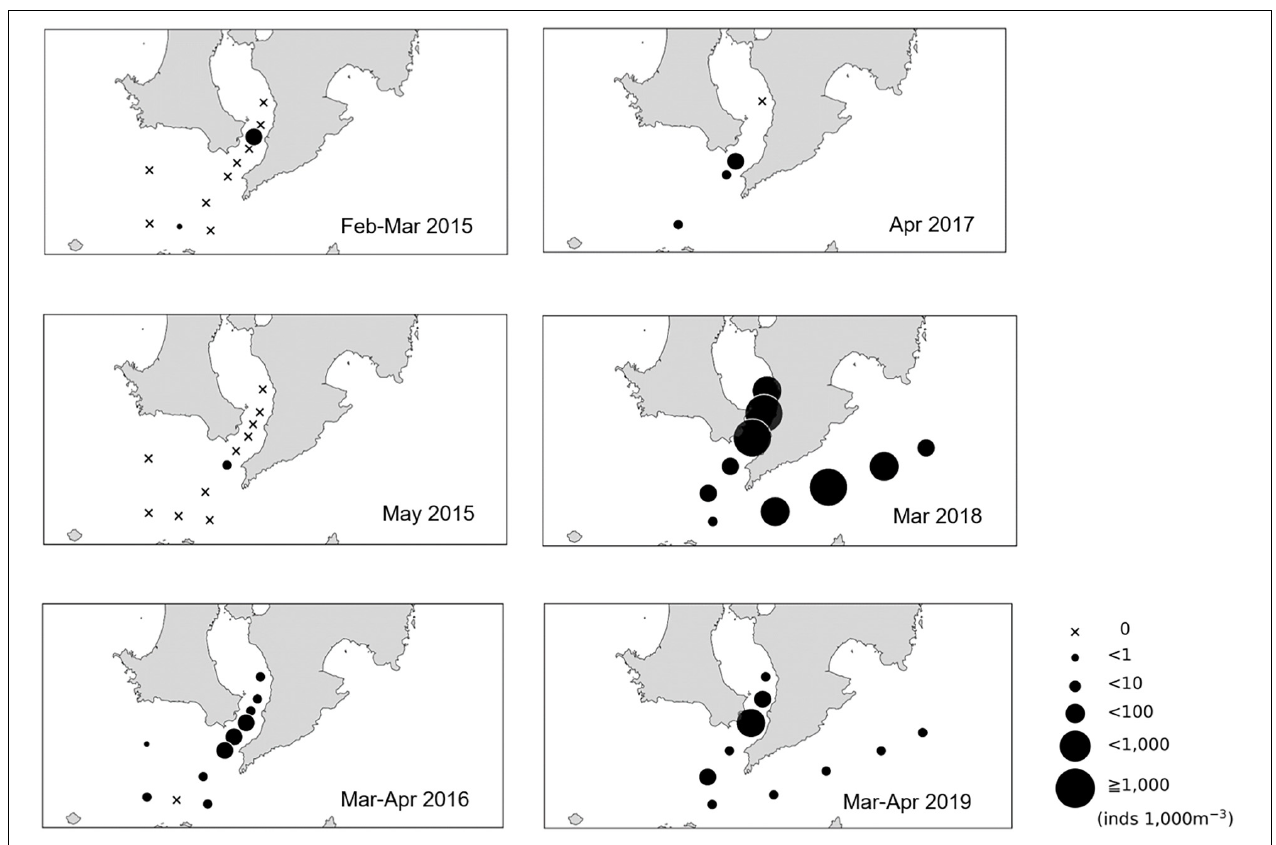
FIGURE 3 | Larval density distribution (per 1,000 m − 3 ) of Scomber spp. in the northern Satsunan area from 2015 to